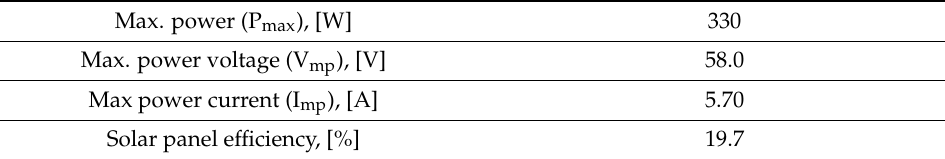
Table 1. PV panel characteristics.